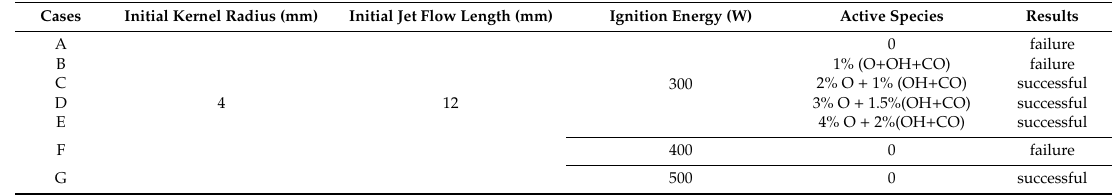
Table 1. The detailed ignition parameters and